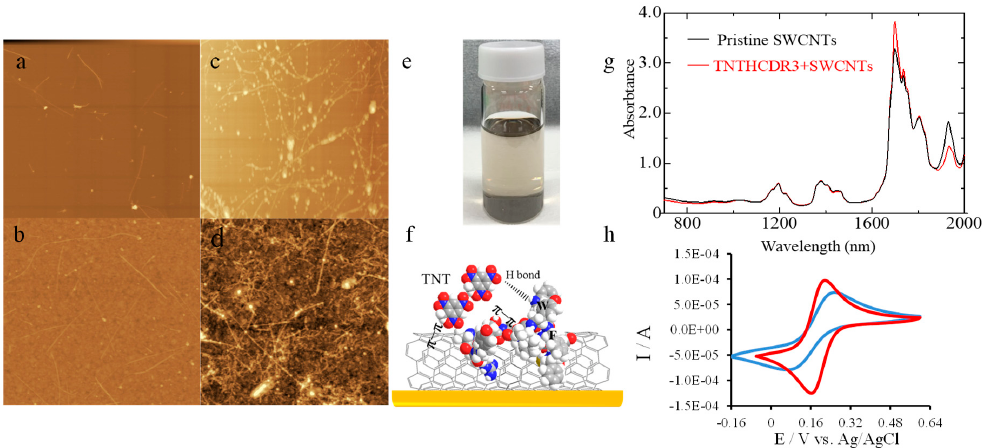
Figure 2. Atomic force microscope (AFM) analysis of the peptide–SWCNT-based SPR sensor